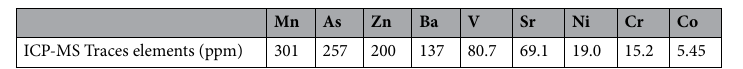
Table 3. Trace elements (in ppm) revealed by ICP – MS in the ink